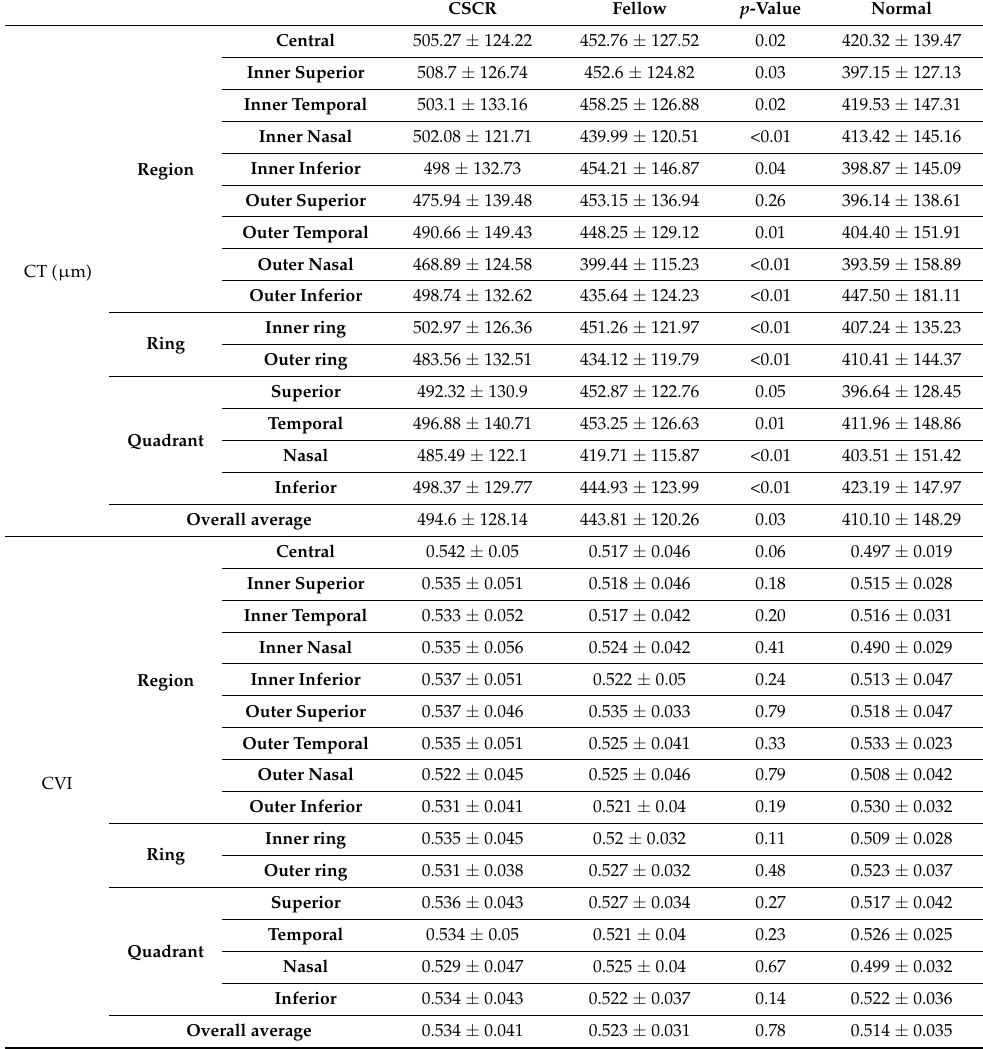
Table 1. Comparison of CT and CVI values in CSCR and their fellow